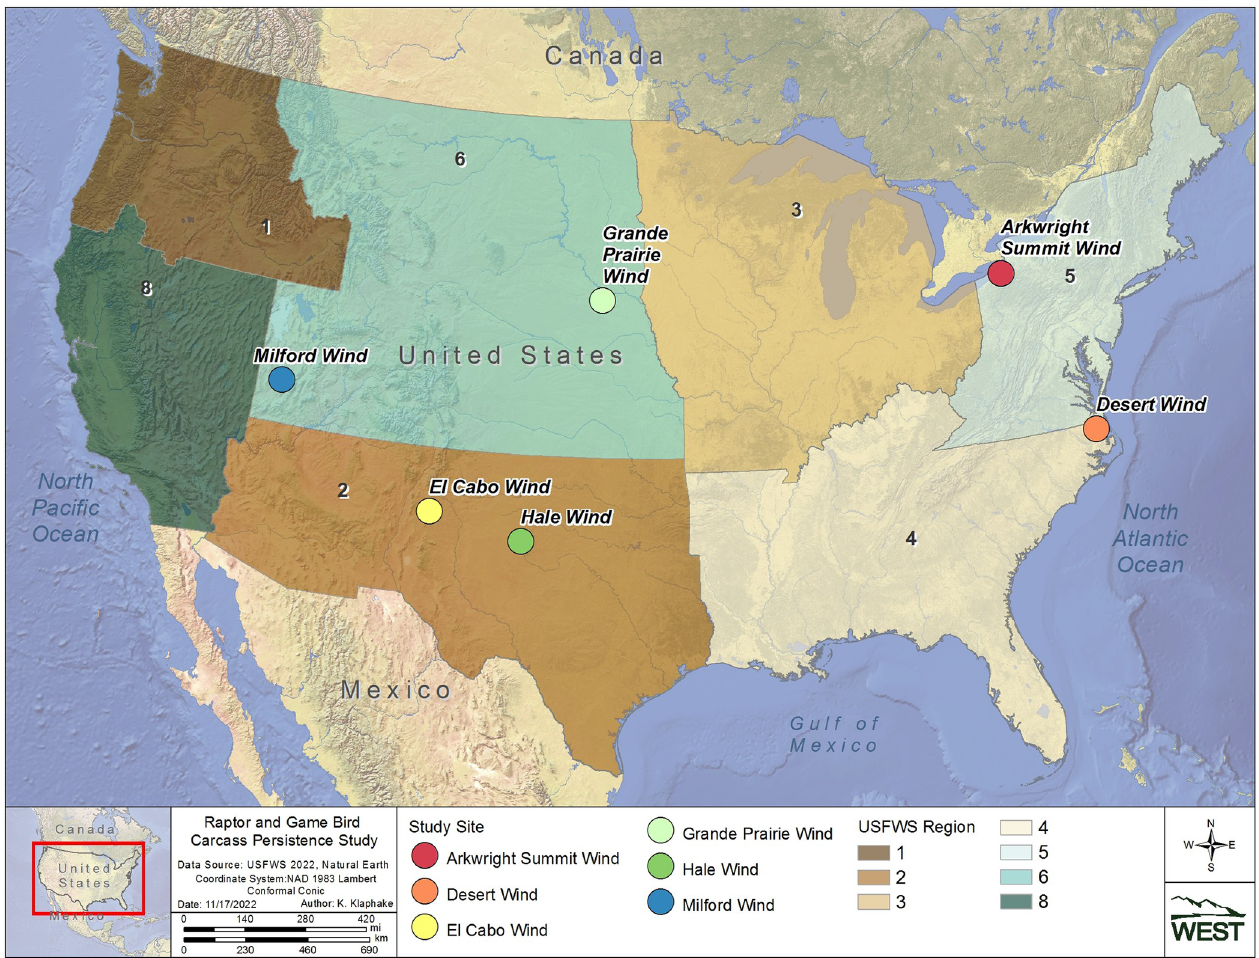
Fig 1. Study site locations for the carcass persistence study conducted in USFWS regions 2, 4, 5, and 6 from June 2020 to August 2021.